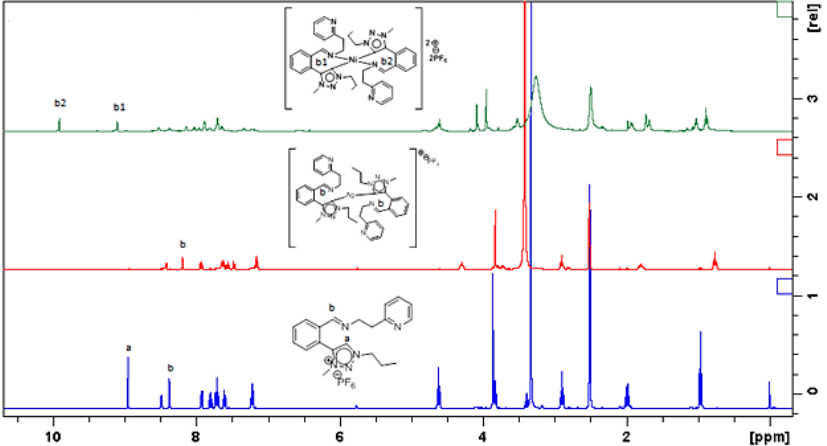
Figure 1. Stacked 1 H NMR spectra showing the disappearance of the carbene (C 5 -H) proton from the ligand precursor (blue line, position a at 8.9 ppm) to silver complex (red line) and on the formation of the nickel complex, 1 (green line).